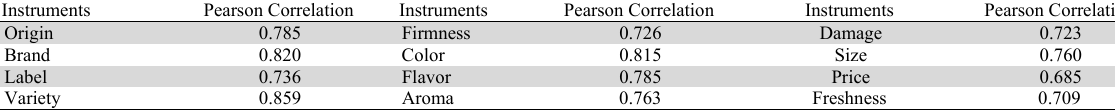
Instrument Tests for Perceived Quality (Cronbach’s Alpha = 0.935)